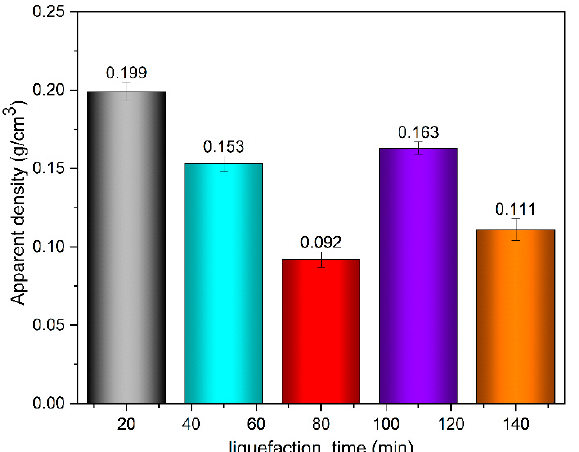
Figure 12. Effect of liquefaction time on the apparent density of polyurethane foaming materials.